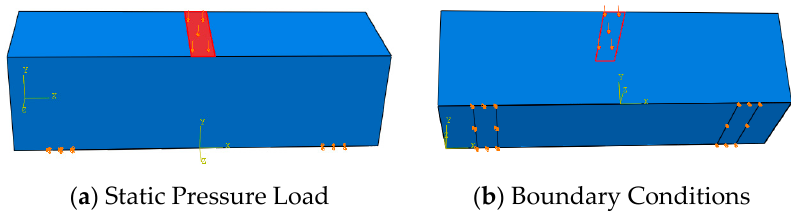
Figure 2. Load and boundary conditions of FRP strengthened concrete beam model. ( a ) Static Pressure Load; ( b ) Boundary Conditions.